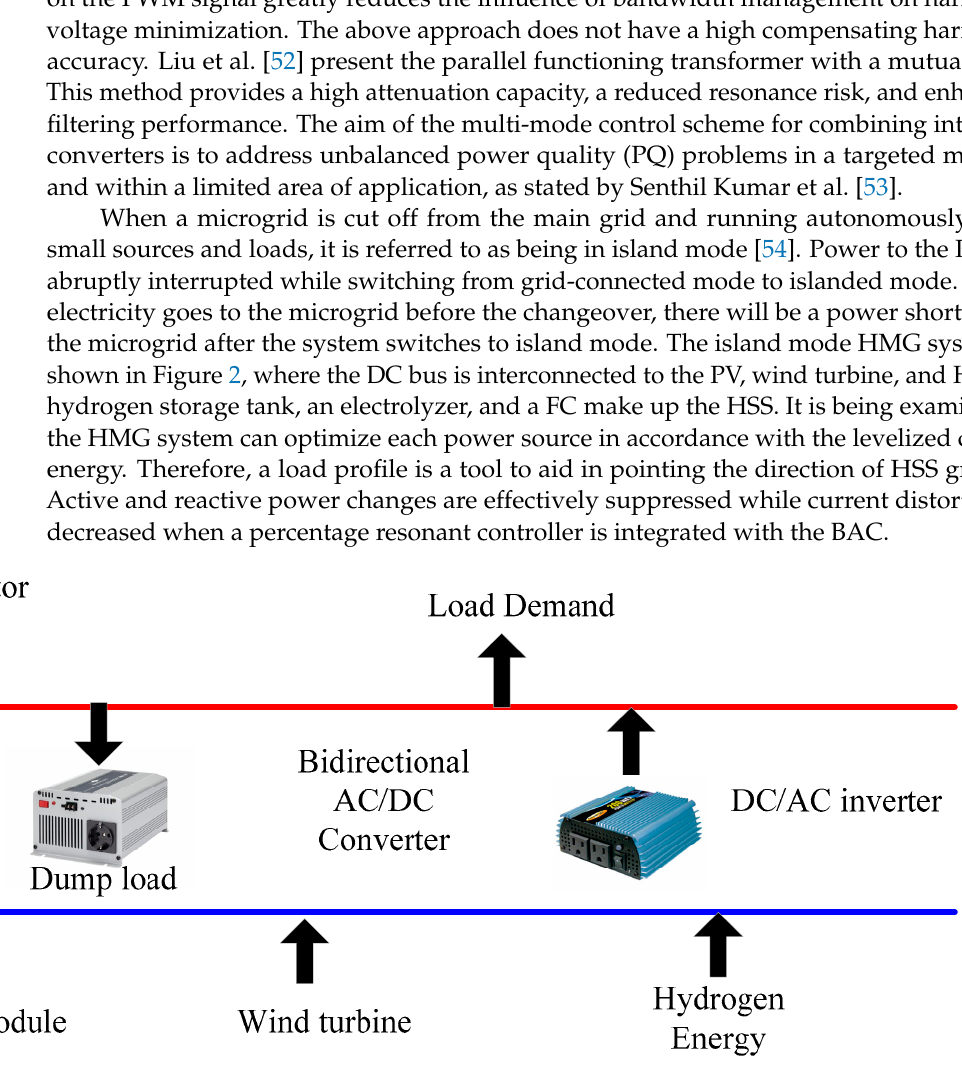
Figure 2. Schematic layout of islanding mode of HMG with HSS. In recent times, meta-heuristic optimizing techniques were applied to identify the best structure, scale, and energy management for hydrogen-based HMG systems. Mohseni et al. [55] evaluated the economics of designing hydrogen-based HMG using several meta